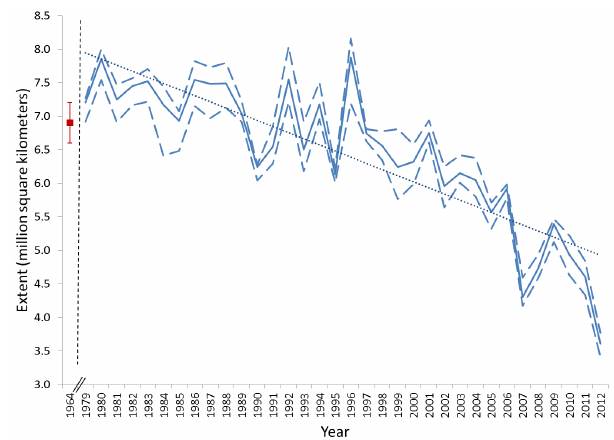
Fig. 7. Time series of Arctic September sea ice extent. The com- bined estimate for 1964 from the Nimbus imagery and the Russian and Alaskan ice charts is to the left, with the passive microwave NSIDC Sea Ice Index values for 1979–2012 in blue. For Nimbus, the error bars represent the standard deviation of the estimates. The blue solid line is the monthly average passive microwave September values, while the blue dashed lines represent a three-day average of the high and low range of daily extents during the